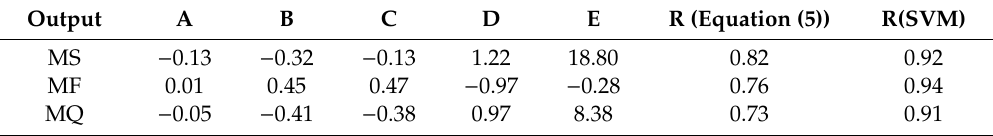
Table 7. The constants used to fit MS, MF and MQ using Equation (5), along with the corresponding correlation coe ffi